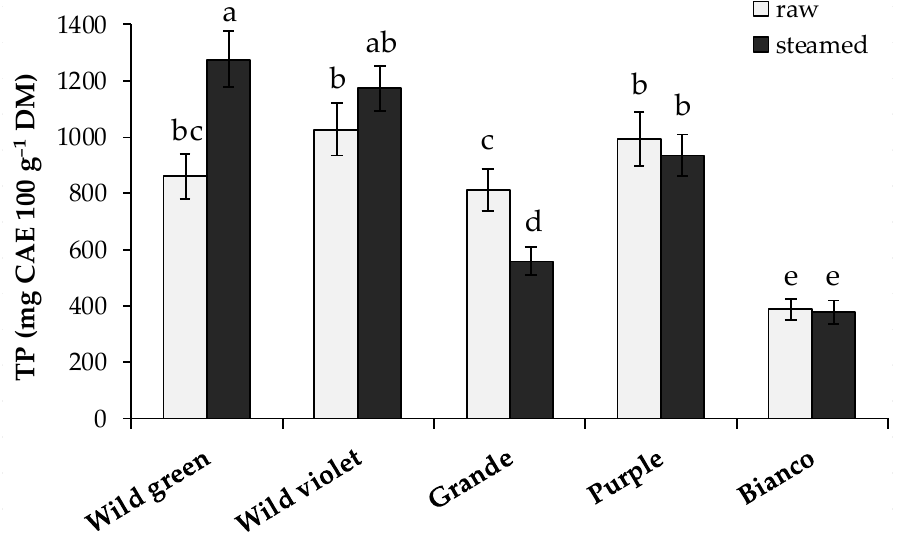
Figure 4. Total phenols (TP) content in raw and steamed asparagus ( p ≤ 0.001). The same letters indicate that the mean values are not significantly different ( p = 0.05). Vertical bars indicate the standard deviation. Grande = ‘Grande’; Purple = ‘Purple Passion’; Bianco = ‘Bianco di Bassano del Grappa’.